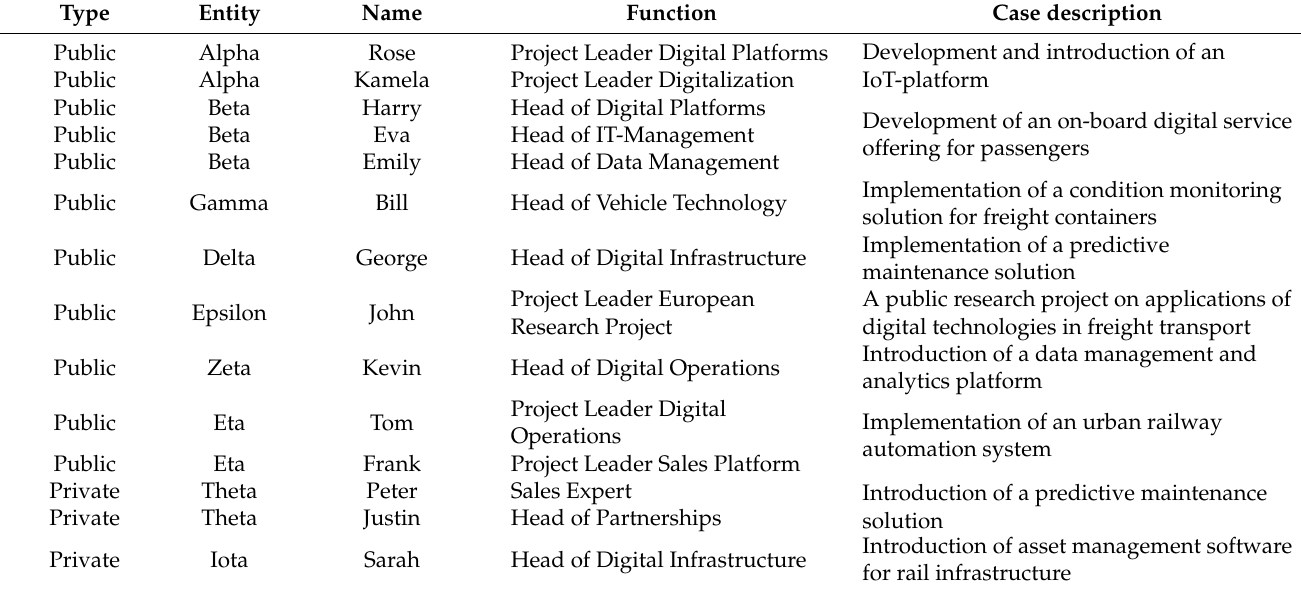
Table 2. Overview of respondents, their functions, and case